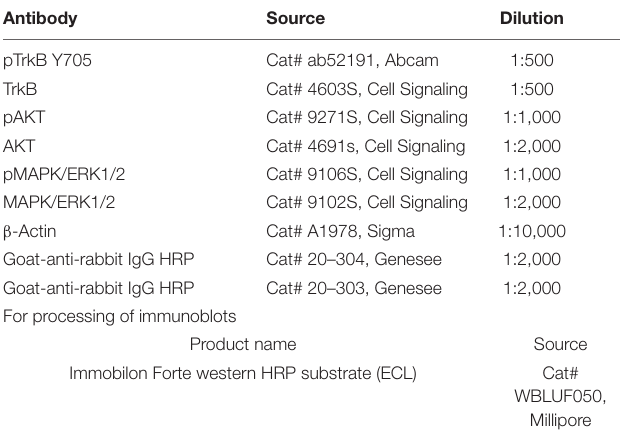
TABLE 1 | Antibodies used in